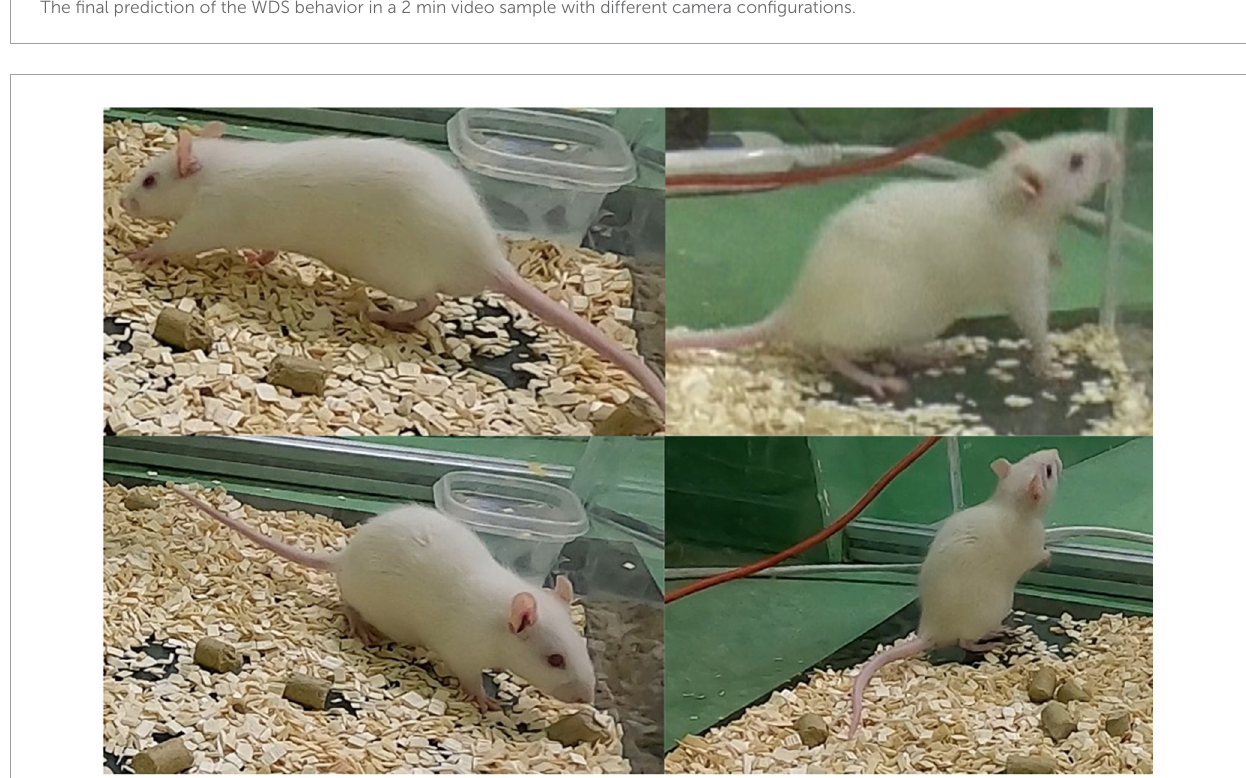
FIGURE9 The final prediction of the WDS behavior in a 2 min video sample with different camera